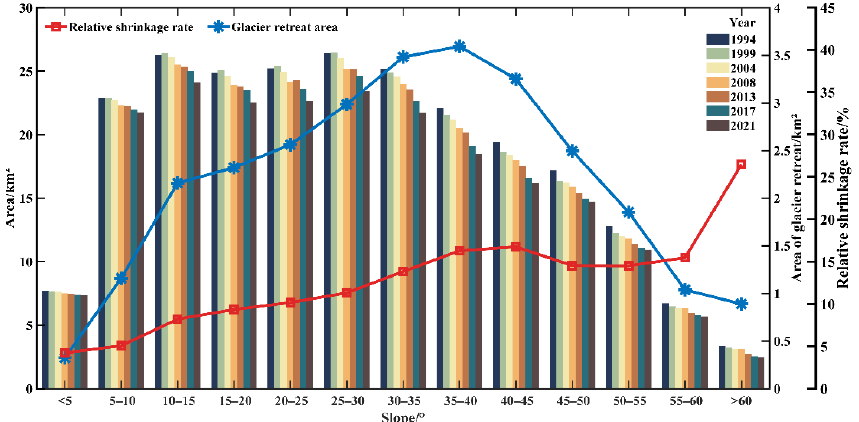
Figure 6. The glacier shrinkage at different slope gradients in 1994, 1999, 2004, 2008, 2013, 2017, and 2021. The total area of glacier retreat (1994–2021) is shown in the blue line and the relative shrinkage rate is shown in the red line. The relative shrinkage rate (1994–2021) is obtained by the shrinking area divided by the glacier area at the beginning of the period.